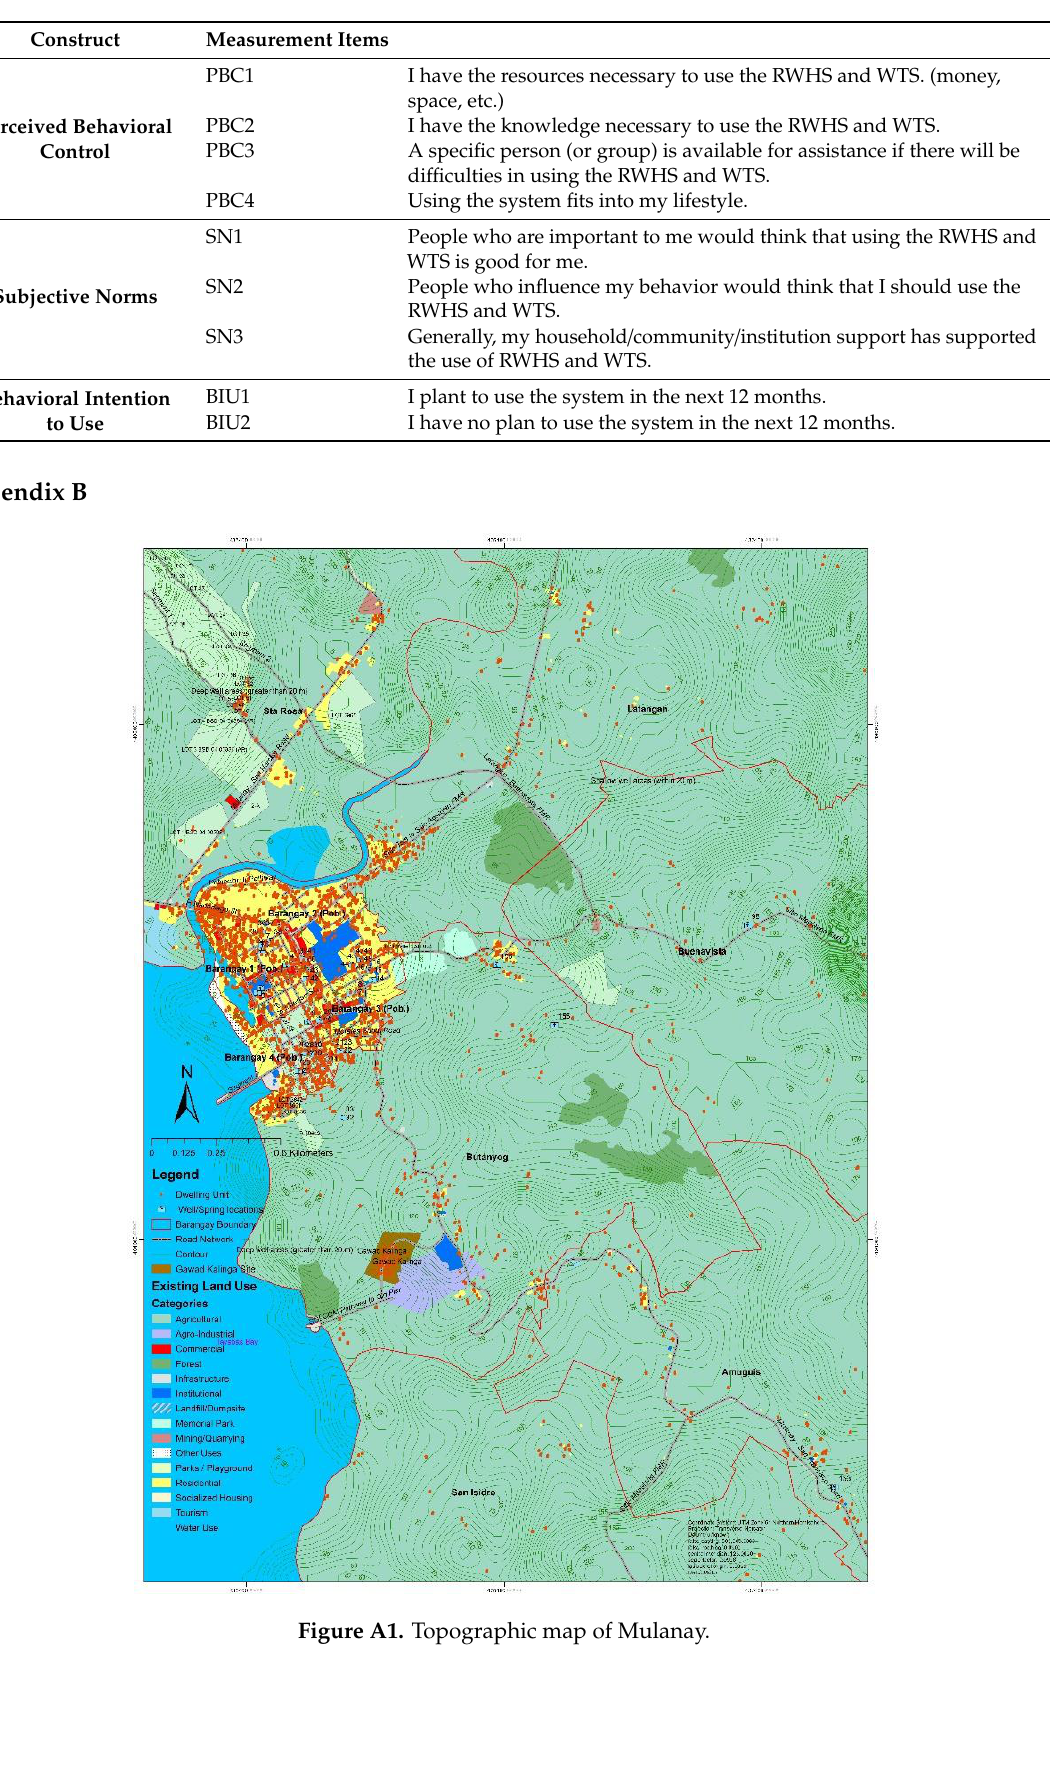
Table A4. C-TAM-TPB Questionnaire for ETS. ( Continued )